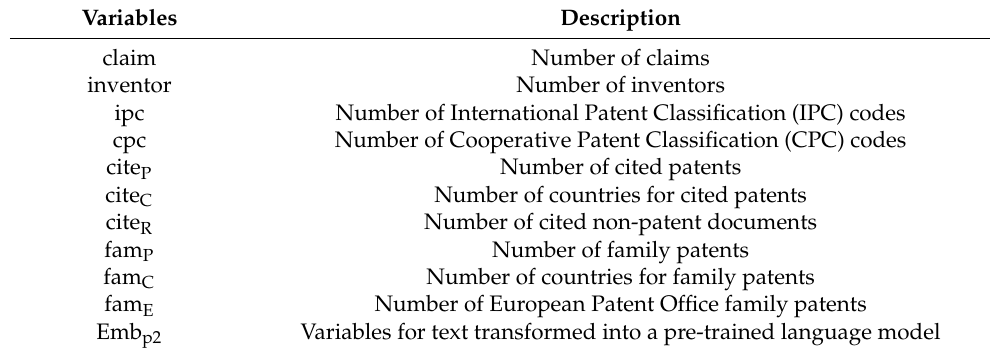
Table 1. Variables used in the proposed